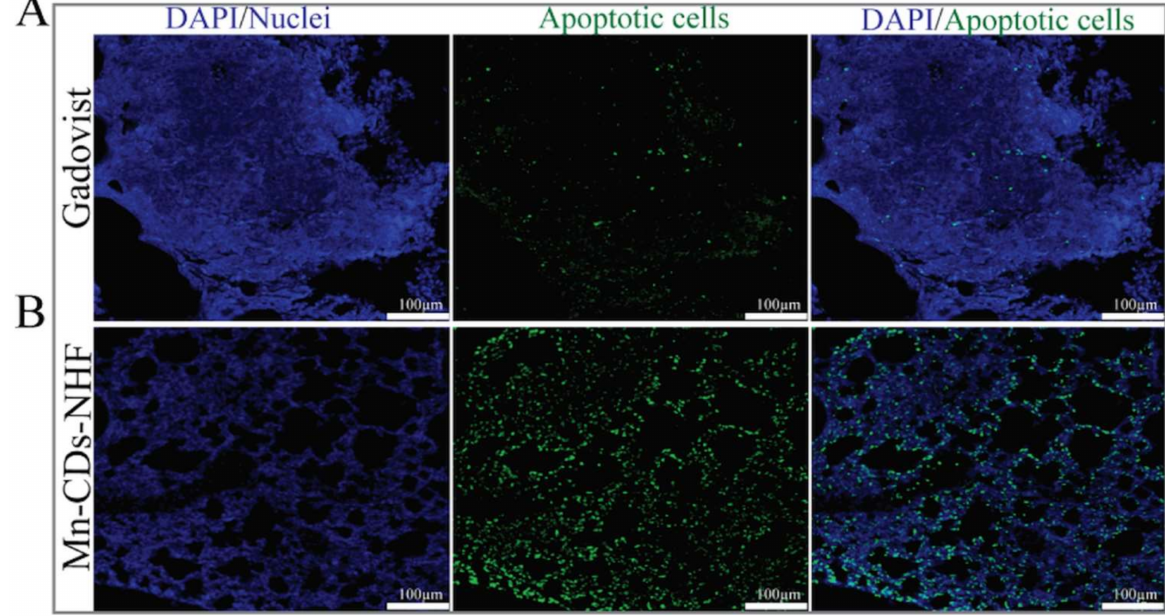
Figure 7. Immunofluorescence staining of apoptotic cells in paraffin embedded murine lung specimens. Pictures acquired at 20 ×